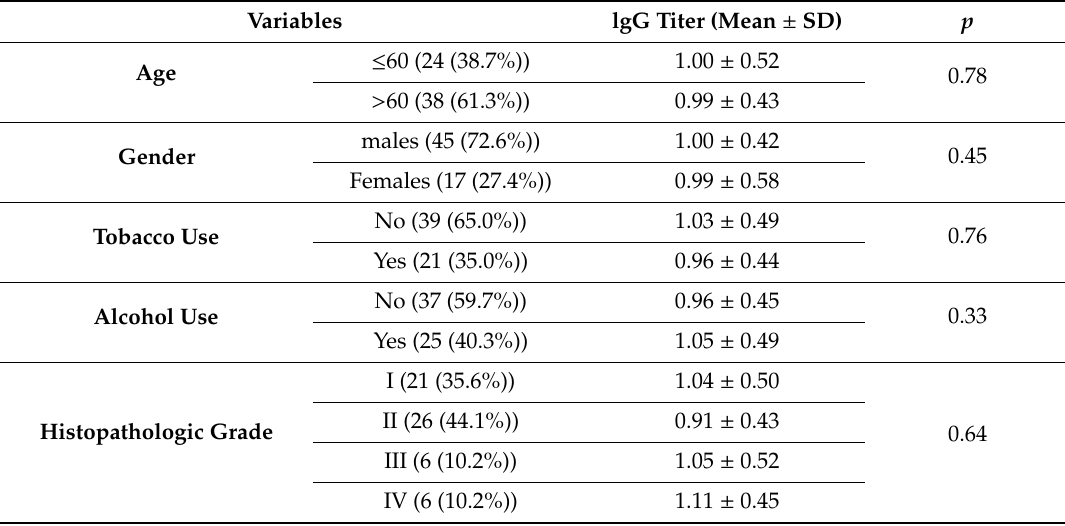
Table 2. Association between serum IgG antibodies against F. nucleatum and the clinicopathological features of